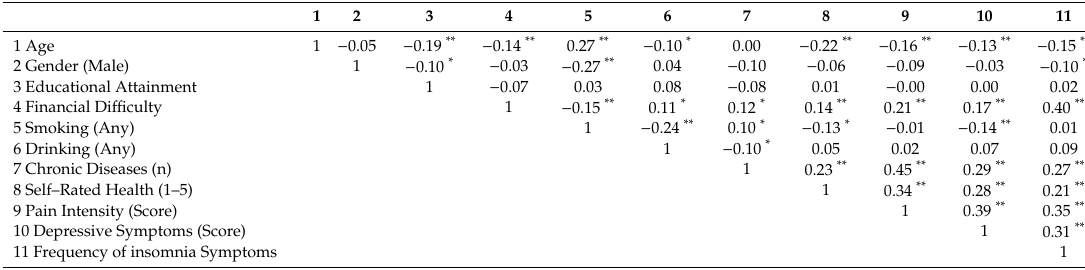
Table 2. Bivariate correlations.